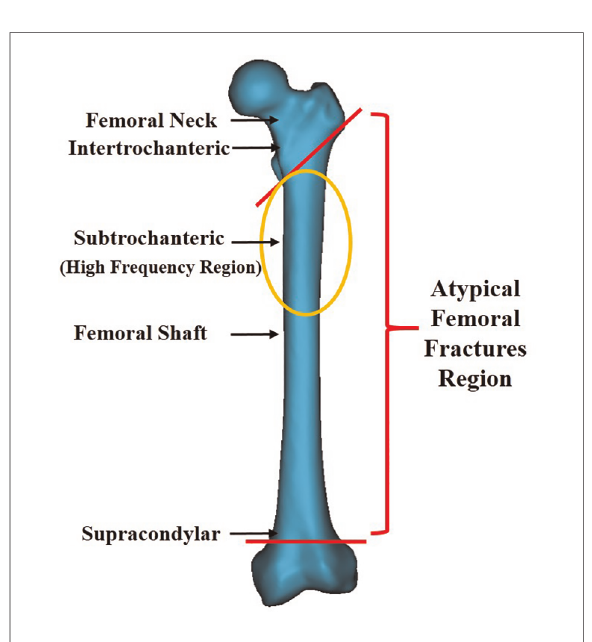
FIGURE 2 The region of atypical femur fractures, yellow circles denote areas of high